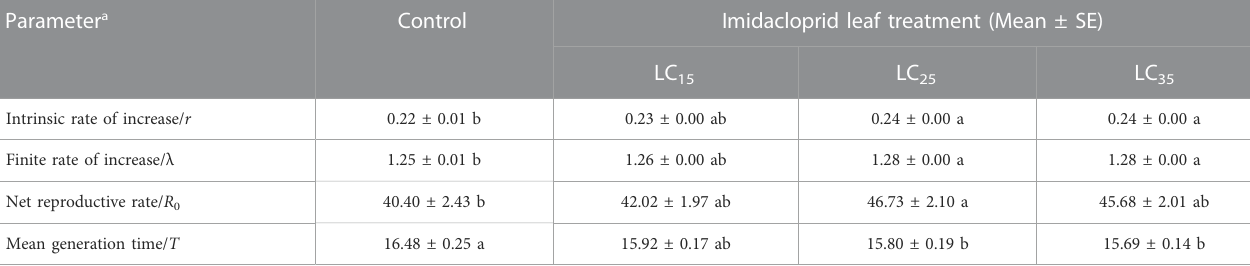
TABLE 2 Sub-lethal effects of imidacloprid on population parameters of the F 1 generation of Metopolophium dirhodum . Parameter